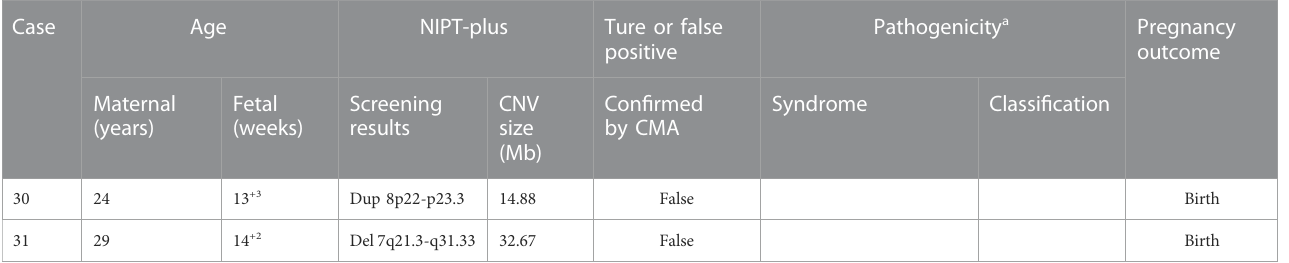
TABLE 4 Performance comparison of NIPT-Plus between high-risk and low-risk groups. Chromosome abnormalities